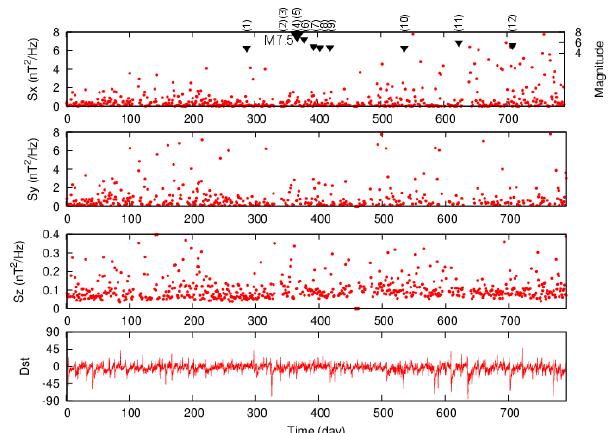
Fig. 7. Temporal variations of the spectral intensity based on WT from 1 September 2008 to 31 October 2010. The first, second, and third panels illustrate the spectral intensity of X , Y , and Z compo- nents at the frequency range of 0.01 ± 0.003Hz, respectively. A red dot presents the daily averaged value. A black triangle indicates the occurrence time of the largest EQ ( M = 7.5) and other EQs listed in Table 1. The bottom panel is Dst